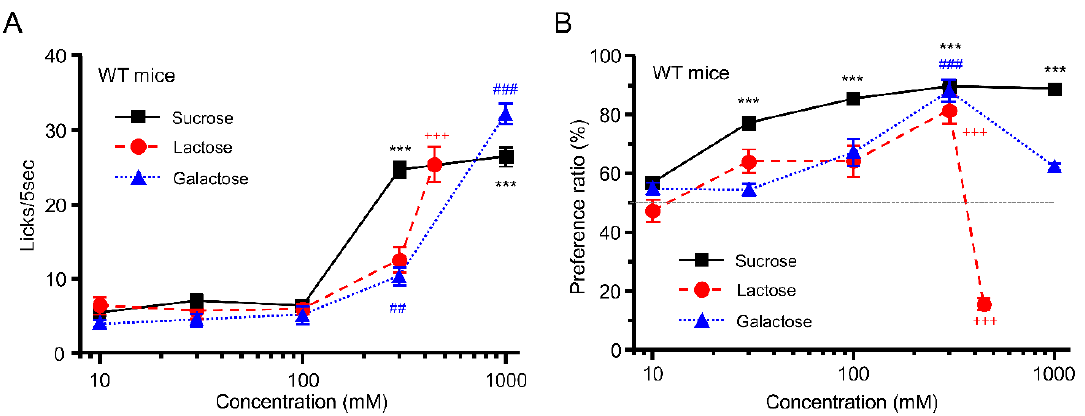
Figure 1. Behavioral responses to sugars in wild-type (WT) mice. ( A ) Number of licks of sucrose (black squares), lactose (red circles), and galactose (blue triangles) in the short-term (5 s) lick test ( n = 7). ( B ) Preference ratio for sucrose (black squares), lactose (red circles), and galactose (blue trian- gles) in the 48 h two-bottle test ( n = 6). ## p < 0.01, *** p < 0.001, +++ p < 0.001, ### p < 0.001, post hoc Tukey highest-significant-difference (HSD) test (vs. 10 mM). All data are presented as the mean ± standard error.